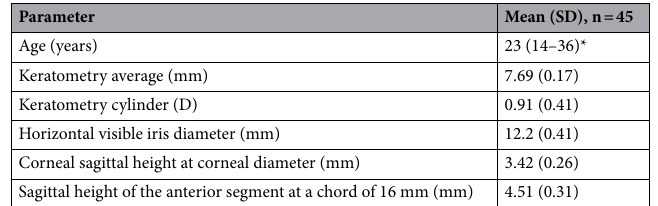
Table 1. Baseline characteristics of enrolled eyes; mean values (standard deviation, SD). *Median